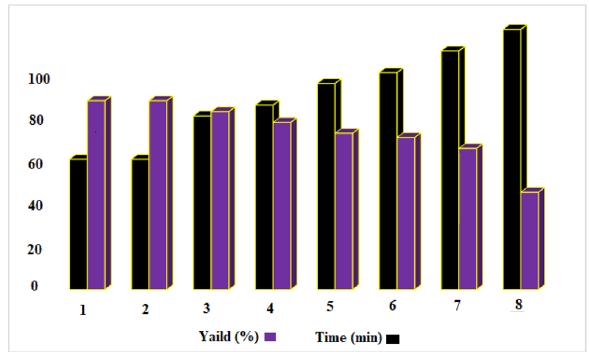
Figure 12. Recyclability of catalyst for the synthesis of pyrazolo[3,4- b ]pyridine